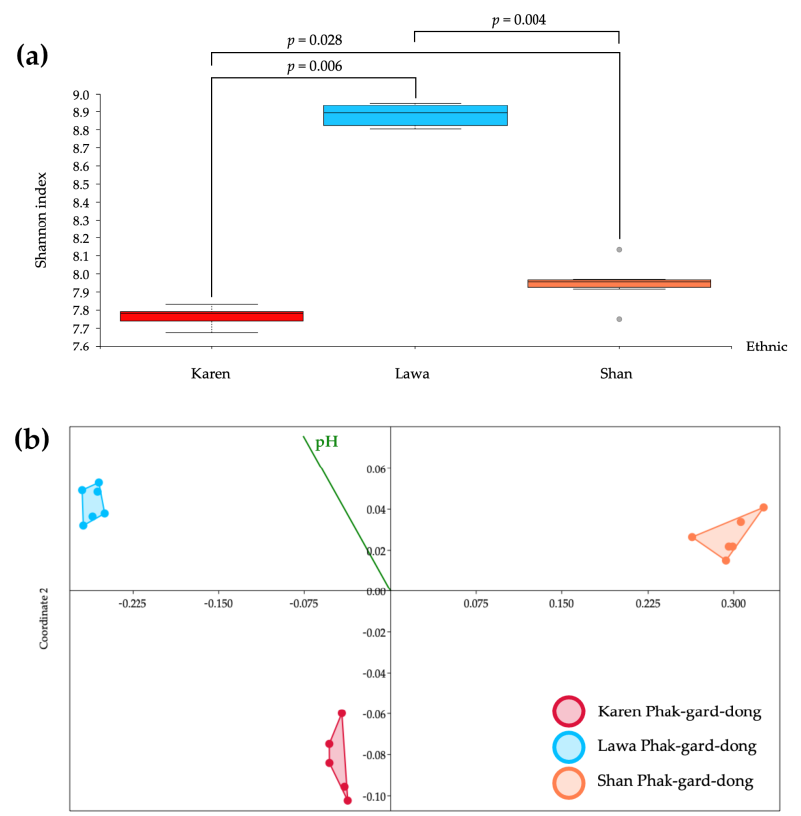
Figure 3. Alpha diversity boxplot with Shannon index demonstrated that the Karen PGD was different from Lawa PGD ( p = 0.006) and Shan PGD ( p = 0.028), and Lawa PGD was different from Shan PGD ( p = 0.004) ( a ). The NMDS plot demonstrated the bacterial diversity differences among the PGDs from the three ethnolinguistic groups ( b ).